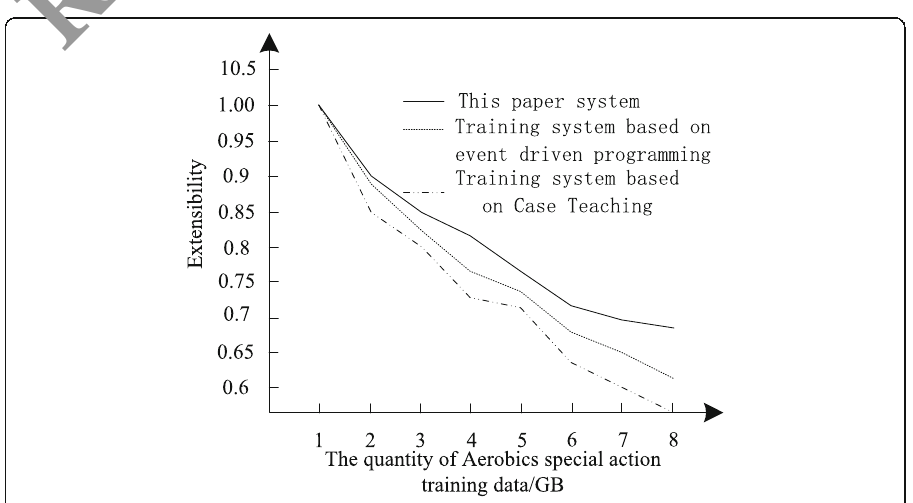
Fig. 11 Comparison of Extensibility of different